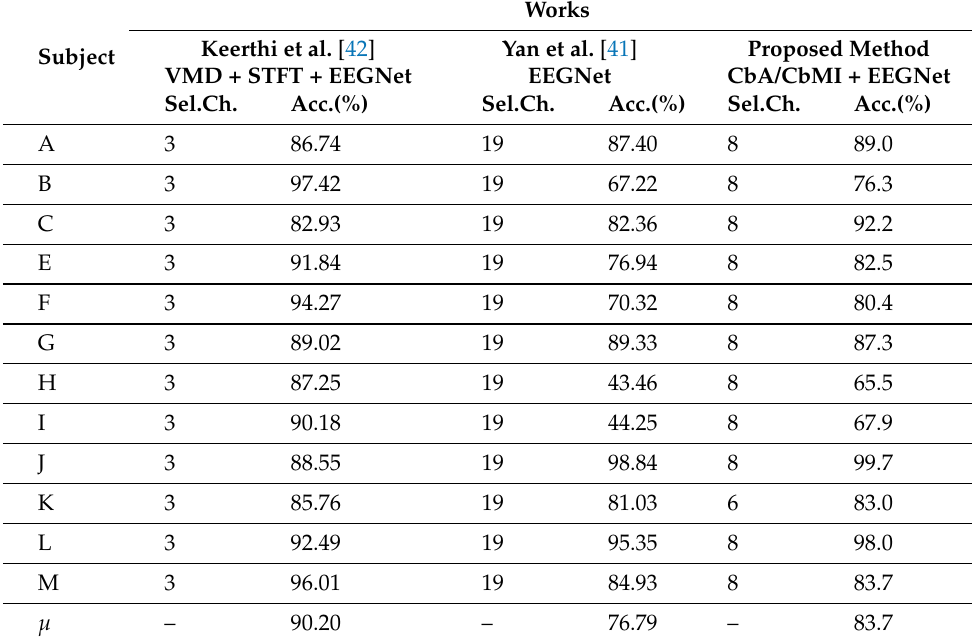
Table 10. Comparison with other state-of-the-art methods related to the Halt dataset. Sel.Ch. means selected channels, and µ is the average classification